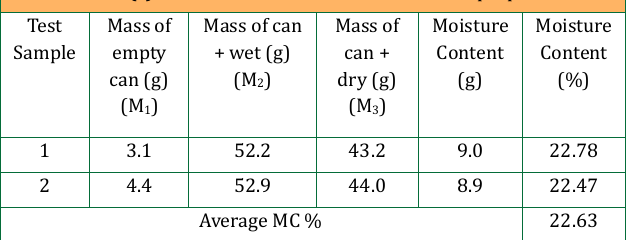
Table 2 (d): Moisture content test results for sample point 4 Test Sample